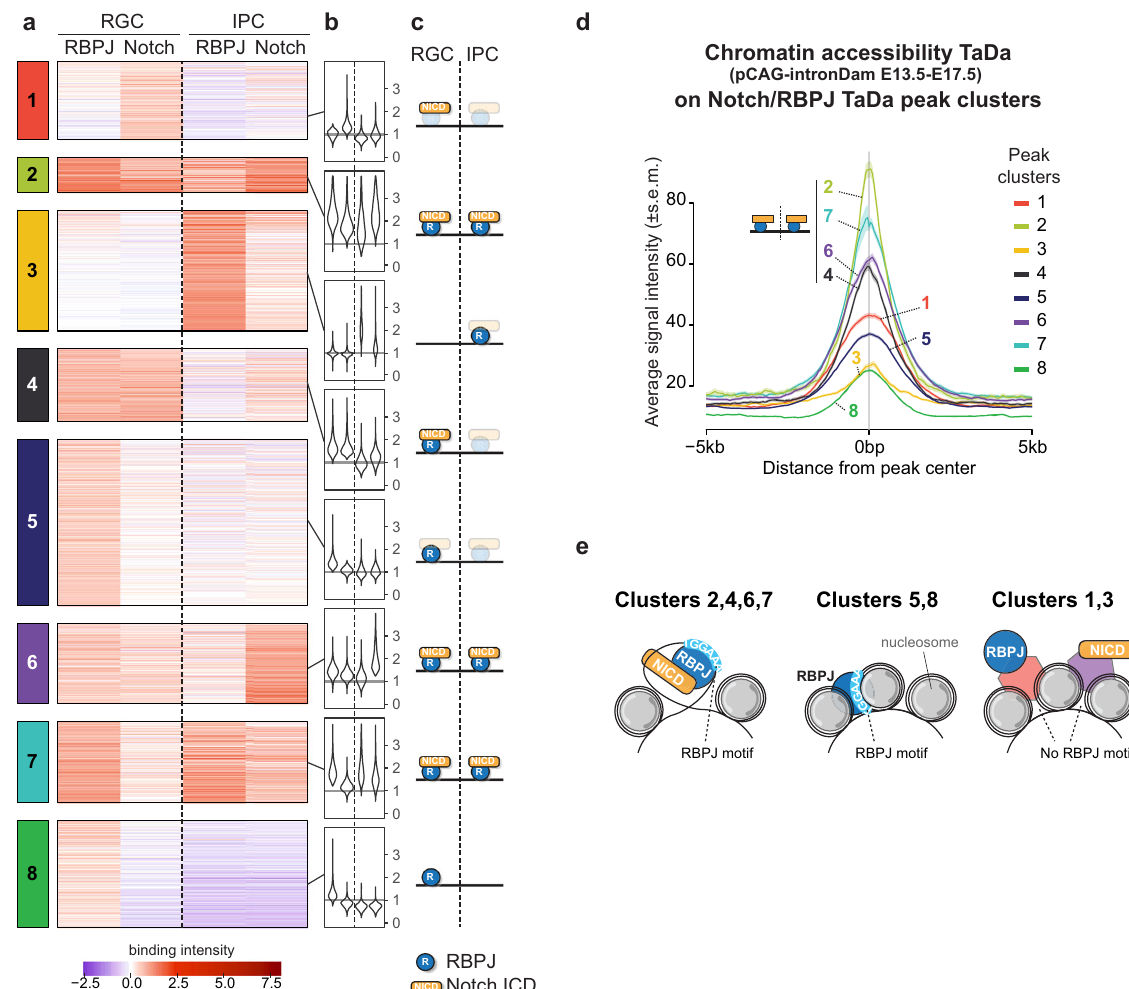
Fig. 3 Dynamic NOTCH/RBPJ binding during neurogenesis. a – c k-means clustering of all regions bound by NOTCH or RBPJ in RGCs or IPCs results in 8 clusters corresponding to distinct binding patterns of RBPJ (blue) and NICD (yellow). Colour scale indicates TaDa binding intensity. d pCAG-iDam average signal (±s.e.m., shaded area) on NOTCH /RBPJ peak clusters. e Peak clusters indicate chromatin accessibility and binding